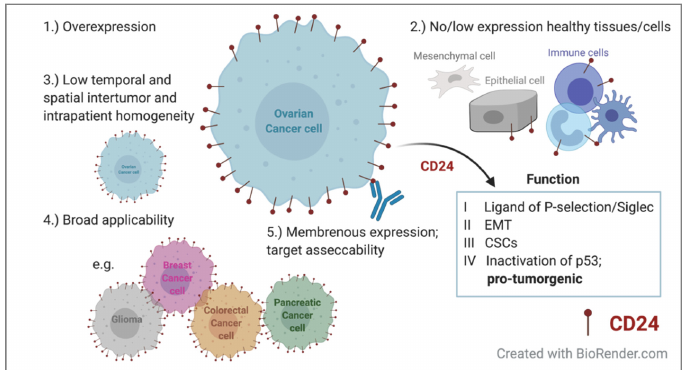
Figure 1. Requirements of a good biomarker for fluorescence image-guided surgery in the context of CD24. It should have ( 1 ) high tumor specificity with high abundance on tumor cells, and ( 2 ) the target should be absent in healthy tissue ( 3 ), while spatial and temporal intratumor heterogeneity should be low [13]. ( 4 ) It should have broad applicability to a wide variety of malignancies and ( 5 ) preferably extracellular target expression for better accessibility to widen its clinical